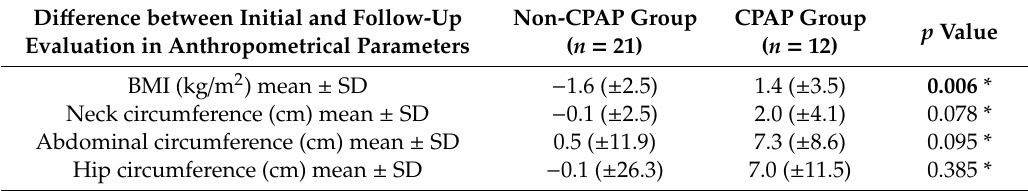
Table 5. Evolution of anthropometrical parameters between initial evaluation and follow-up. Difference between Initial and Follow-Up Evaluation in Anthropometrical Parameters